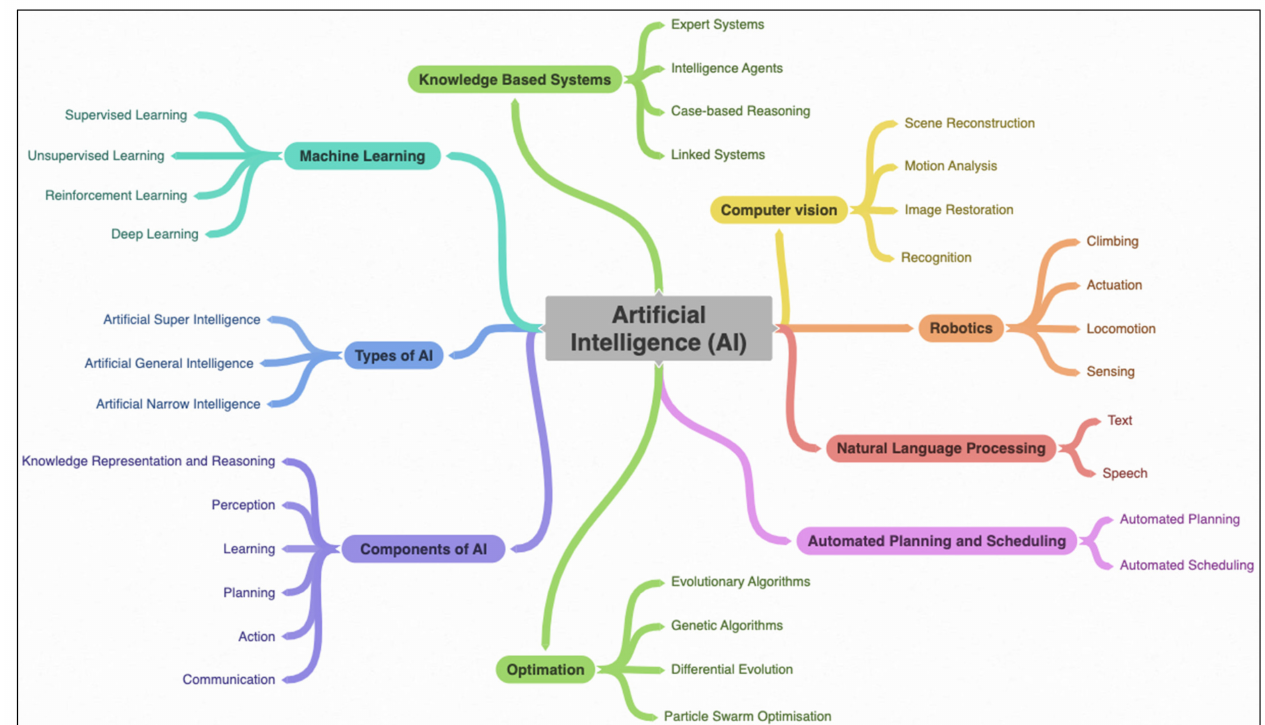
Figure 2. Components, types, and subfield of AI, derived from